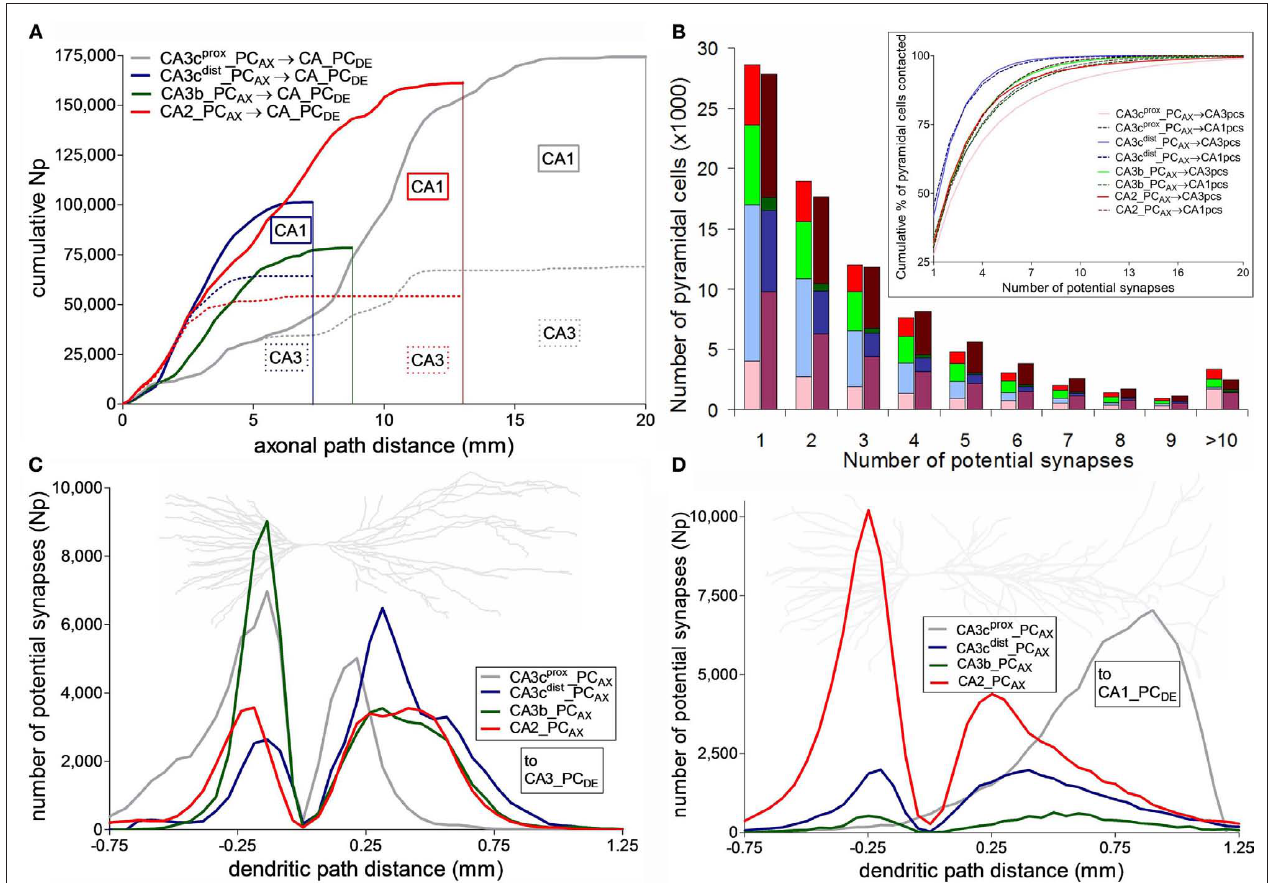
pyramidal cells contacted by any of the four axonal arbors. Inset shows the cumulative proportion of pyramidal cells contacted with up to a given number of potential synapses. (C,D) Potential synapse distributions for the four CA3/2 axonal arbors along the dendrites of CA3 (C) and CA1 (D) pyramidal cells. Negative and positive path distances correspond to basal and apical dendrites, respectively. The background neuron images are representative dendritic arbors of CA3 and CA1 pyramidal cells